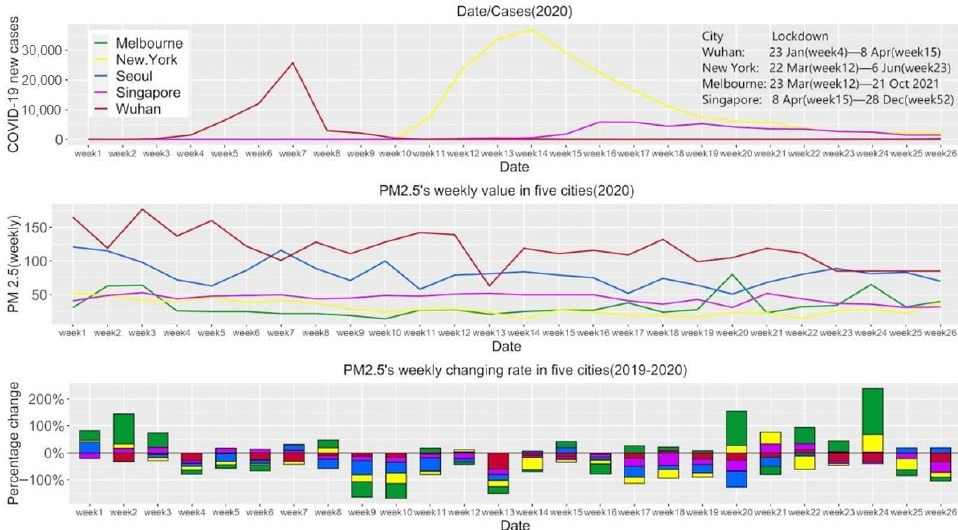
Figure 12. The relationship between PM2.5 , new cases, and lockdowns in five cities during weeks 1 to 26 of 2020.